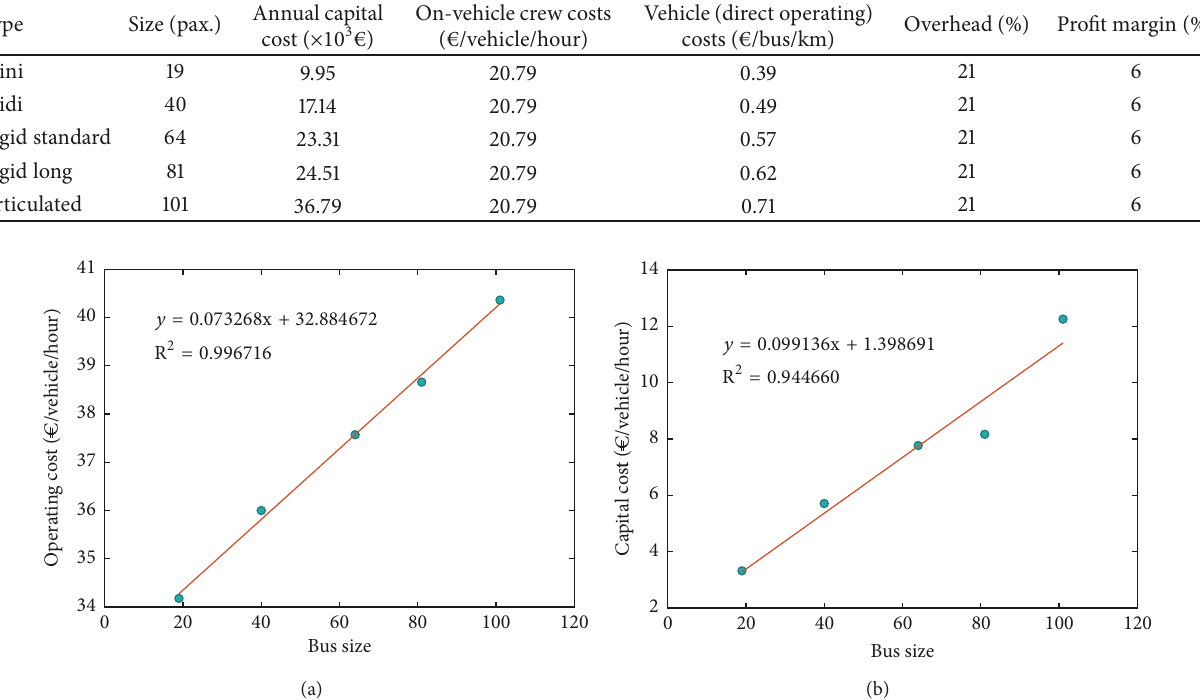
Table 3: Original data used in the model. The size consists of seated and standing capacity. The overhead and profit margin are based on the total operating cost, which is the sum of the on-vehicle crew cost and the distance-related direct operating cost. Data source: Australian Transport Council [7].